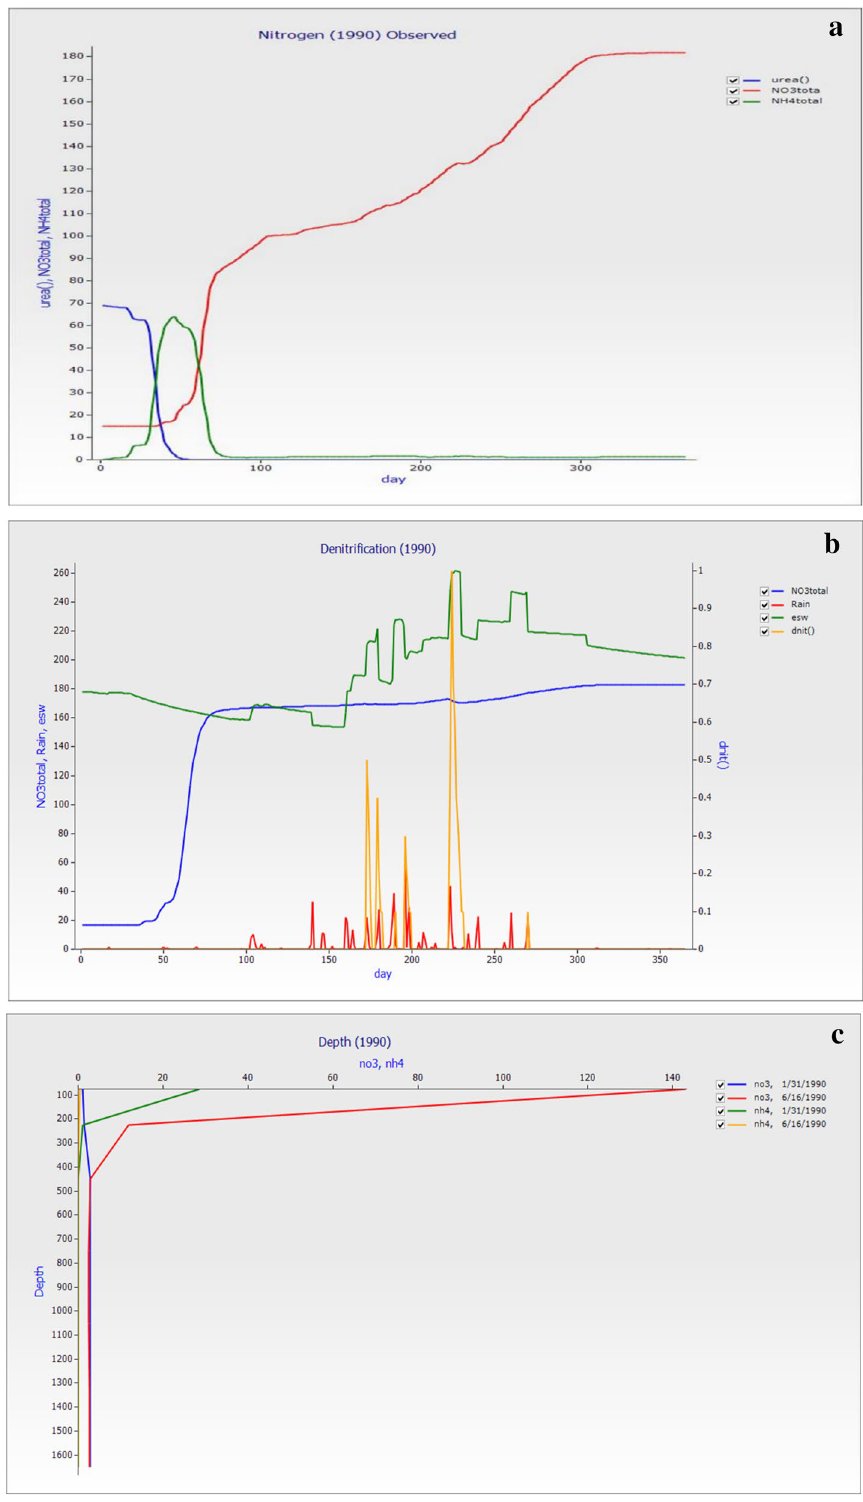
Figure 5. The graph was created for the year 1990 were ( a ) Date versus urea, total ammonium, and total nitrate, ( b ) Date versus Rain, DNIT (on Right Hand Axis), esw (extractable soil water) (mm), and total NO 3− –N (kg ha −1 ) and total NH 4+ –N (kg ha −1 ) ( c ) distribution of nitrate through the soil profile throughout the